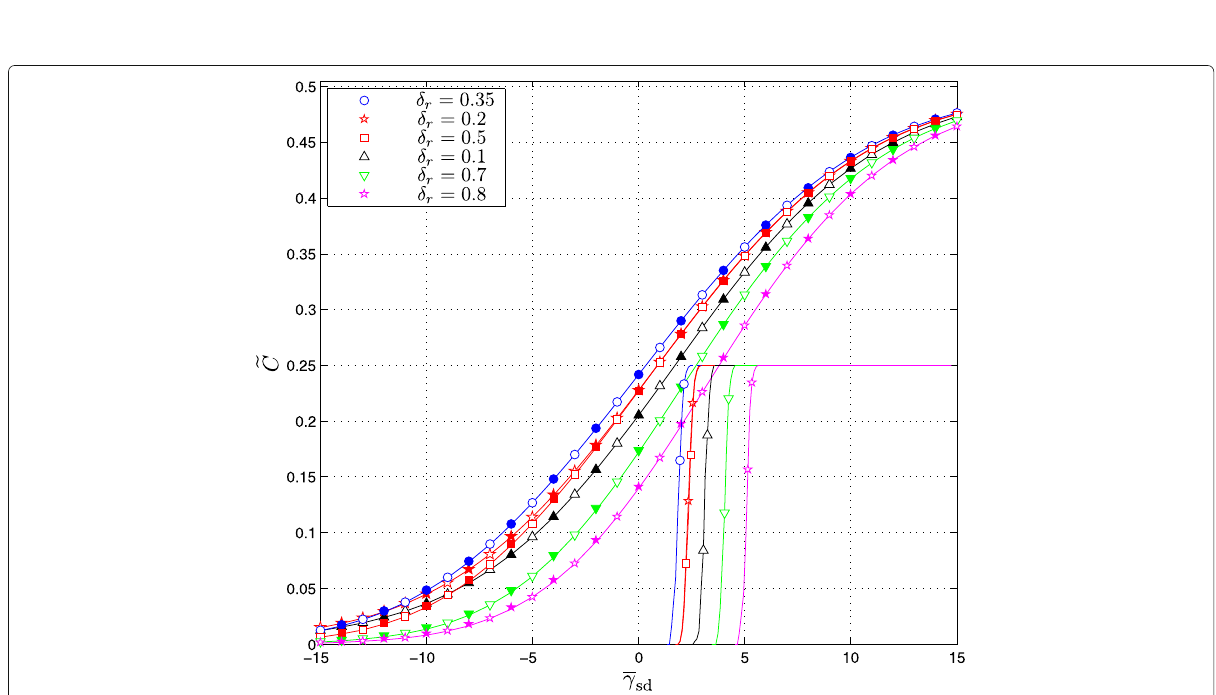
Fig. 3 Throughputs and BICM capacities of a two-hop cognitive relay channel as a function of γ sd , for different relay positions δ r and fixed ratio = d / d = 1 . For different relay positions δ δ p rp rd obtained using the exact L values, and hollow markers correspond to simulation results obtained using the max-log approximation of L value ([9], Eq.